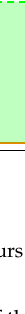
Figure 7. The intersection of the profile line and the threshold line is calculated by linear interpolation between the data points of the profile, located nearest to the threshold line. This additional data point allows more accurate calculation of the area enclosed between profile and threshold line for the subsequent COG